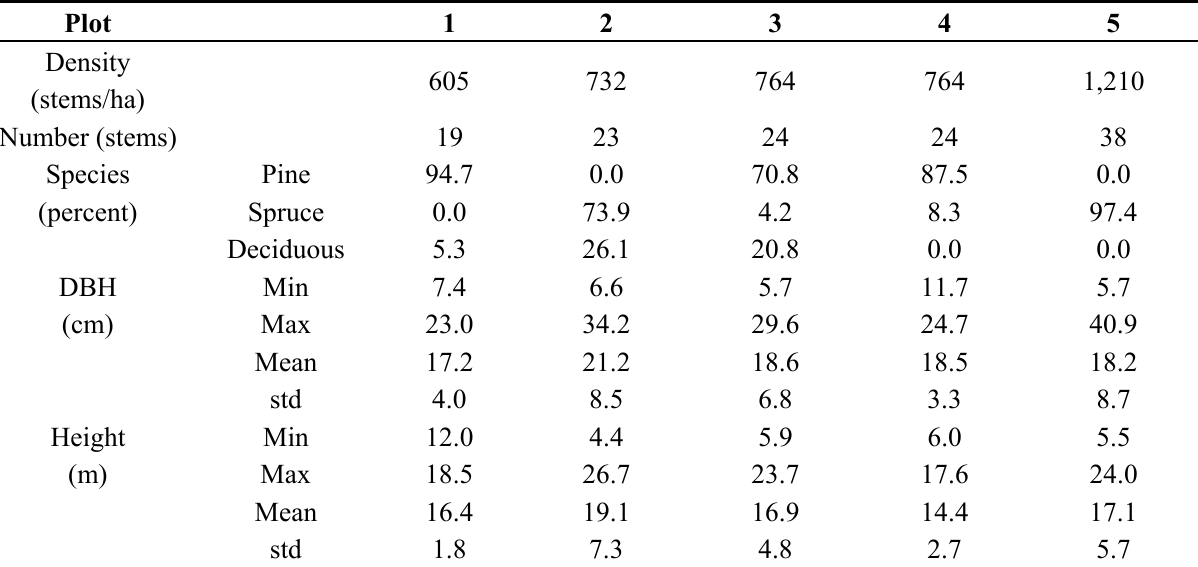
Table 1. Descriptive statistics of the study